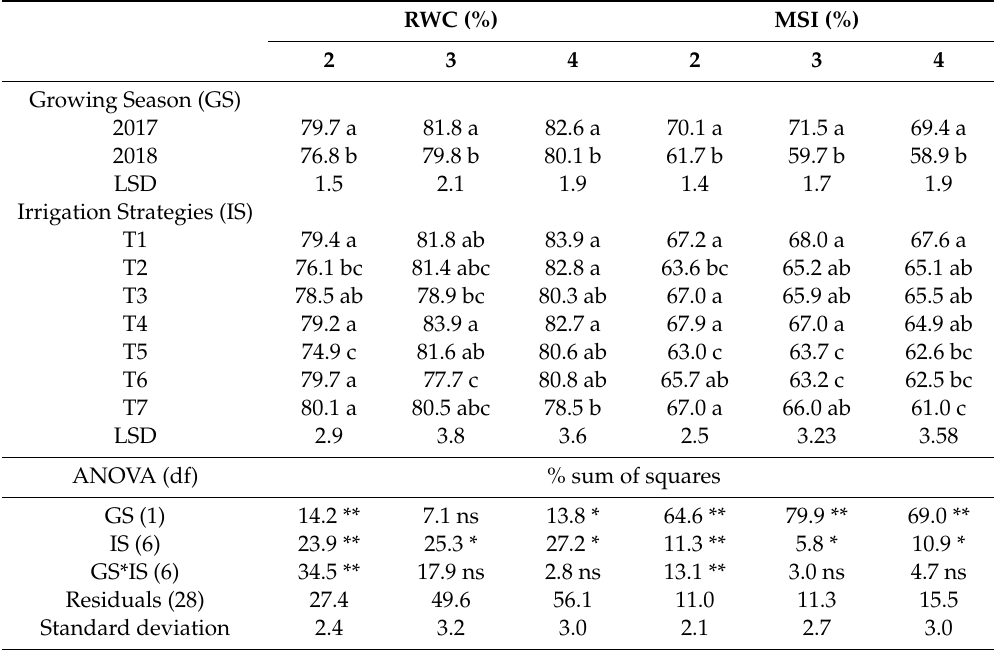
by the IS ( p > 0.05; data not shown), but at the end of the vegetative growth (stage 2), both parameters were a ff ected ( p ≤ 0.01) by the GS, IS, and their interaction (Table 2). There were no di ff erences between the IS in 2017, while in 2018, T2 and T5 led to lower values ( p ≤ 0.01; Table 3). At the bulbing and bulb ripening stages, the interactions were not significant (Table 2) for the RWC or MSI, and these lower values corresponded to the strategies of severe water restriction (50% IWR) in the corresponding stages (T6, T7). Table 2. Effects of the growing season and the irrigation strategy on the relative water content (RWC) and membrane stability index (MSI) at the end of the vegetative growth (2), bulbing (3), and bulbing ripening (4) stages.